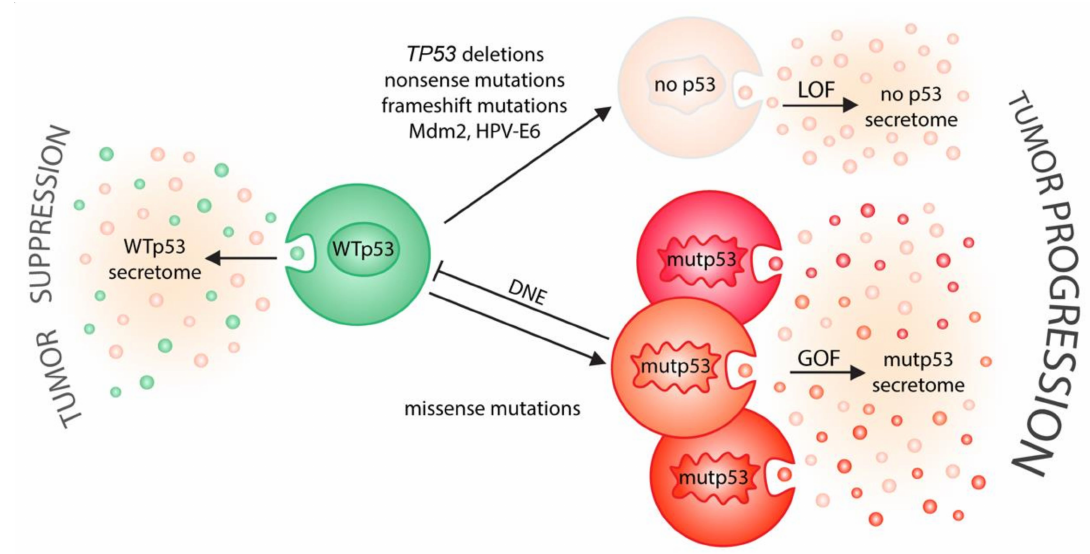
Figure 2. p53 status shapes tumor–host communication via extracellular vesicles. On one side (left), wild-type p53 induces the secretion of EVs that relay tumor suppressive signals to the microenvironment. On the other side (right), cancer-associated alterations in p53 status drive tumor progression by neutralizing the secretory e ff ects of wild-type p53 (LOF, loss-of-function; DNE, dominant-negative e ff ect) and / or by creating a mutant p53-specific EV secretome (GOF, gain-of-function) that is likely di ff erent for distinct missense mutations.